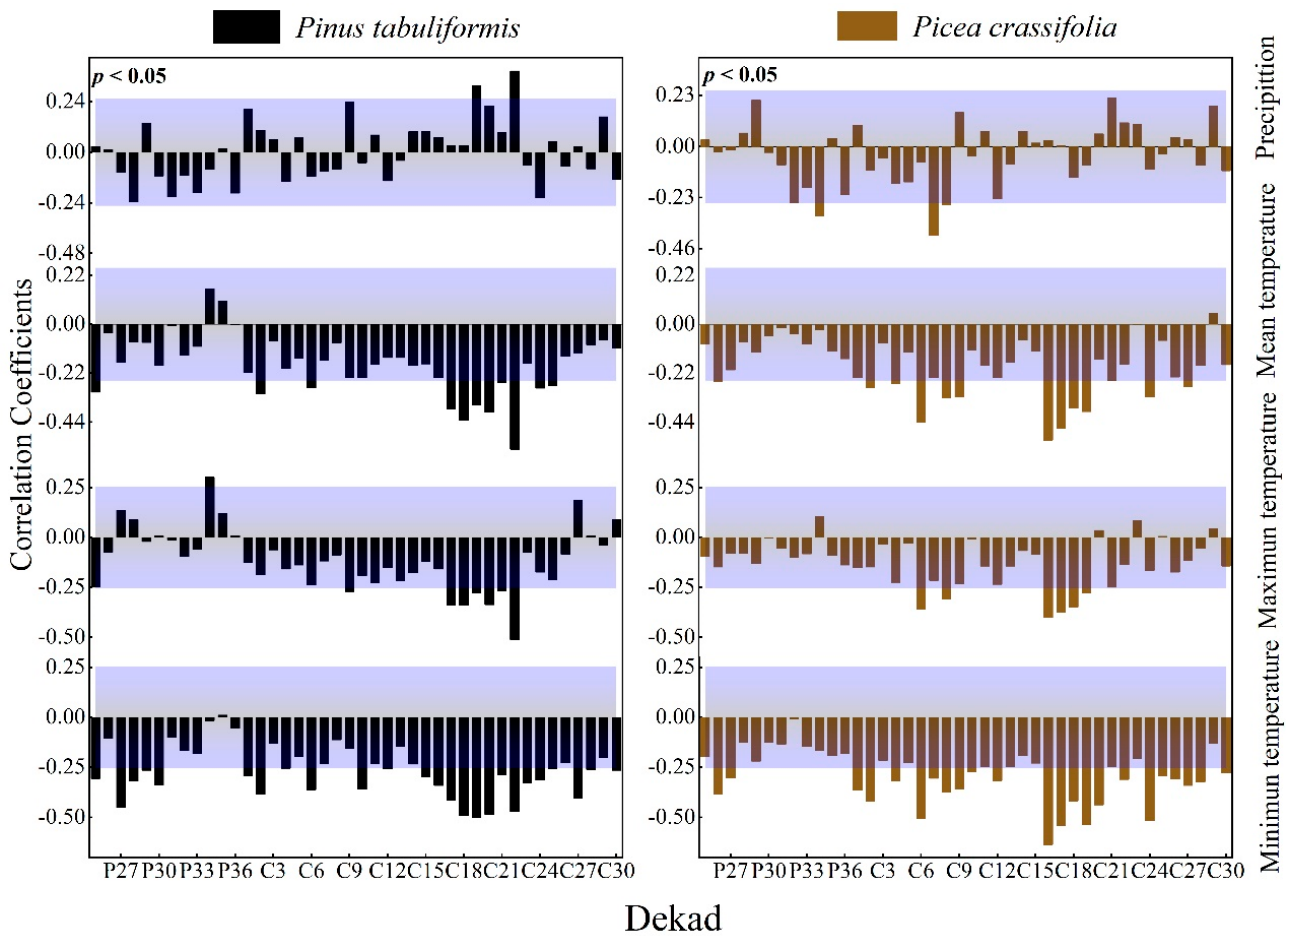
Figure 5. Response of the radial growth of trees to dekad values of climatic factors (Beyond the top of the purple shade, p values are positively correlated ( p < 0.05), lower than the part in purple shadow indicates that p values are negatively correlated ( p < 0.05).